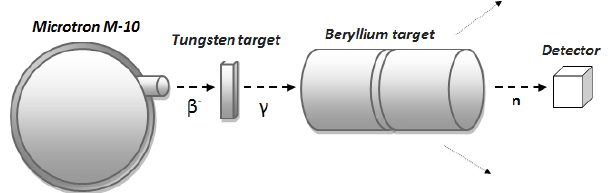
Fig. 1. Schematic of the experiment: accelerator microtron M-10, tungsten gamma converter, the beryllium target and the activation target